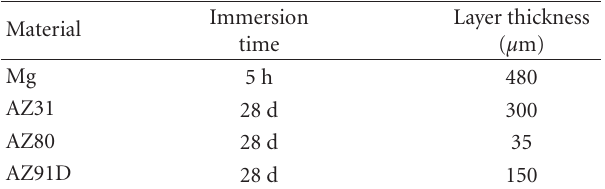
Table 3: Representative thicknesses values of the corrosion layers adhered to the metal surfaces.